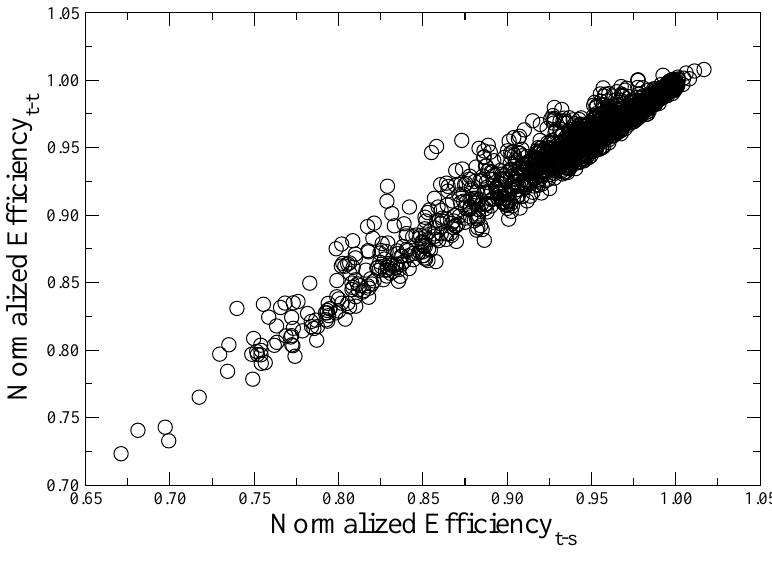
Figure 8. Comparison of η ts and η tt